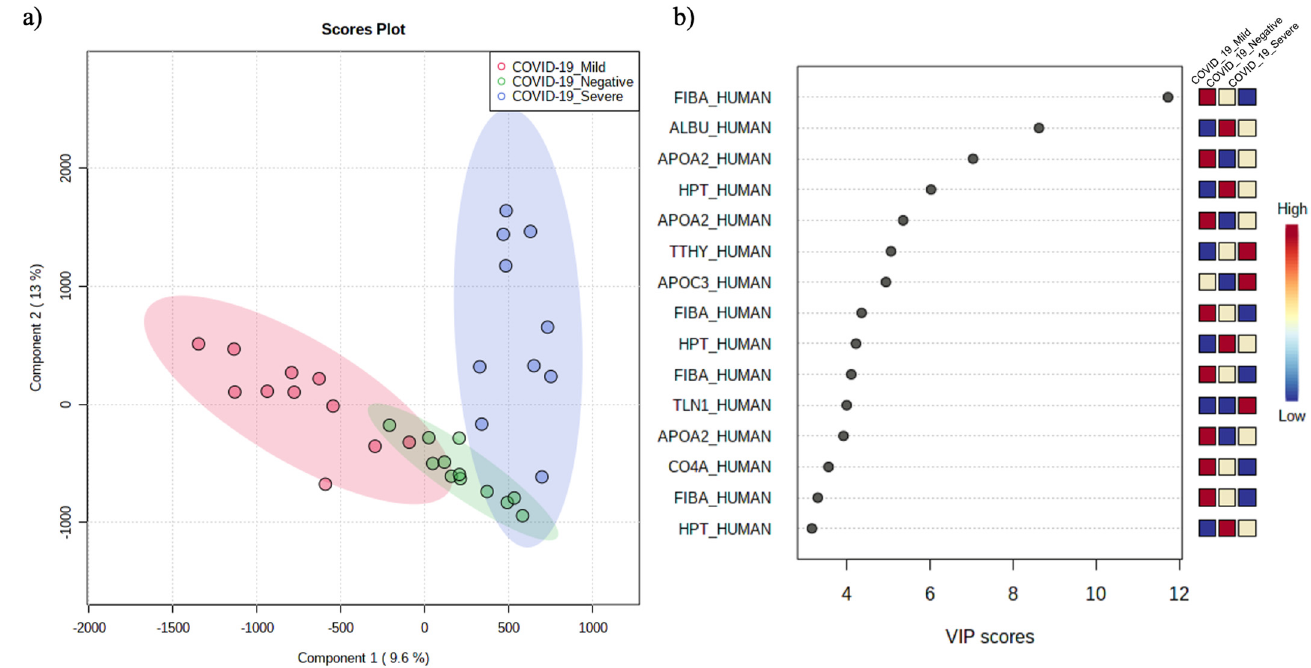
Figure 3. PLS-DA ( a ) and VIP score ( b ) summarizing the most prominent peptides contributing to the observed phenotypic variations in the COVID-19 peptidome.